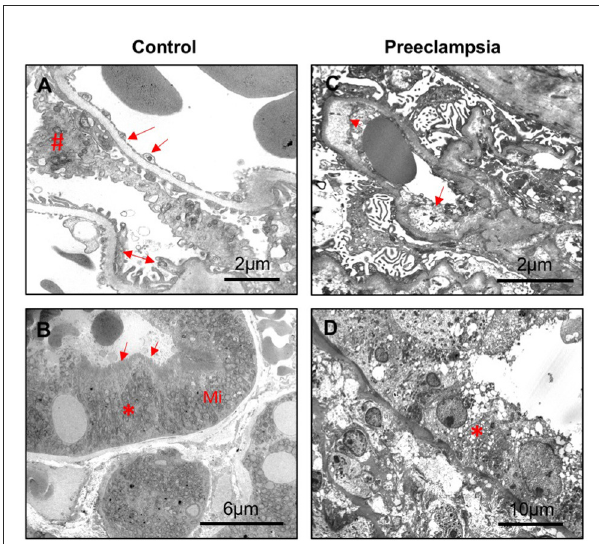
FIGURE3 Representative electron microscopy of kidney tissue sections from a control and a preeclamptic cases. (A, B) control; (C, D) preeclampsia. (A) Segment of glomerulus showing wide opened capillary loops covered by basement membrane and podocyte foot processes; endothelial lining is highly fenestrated. Arrow: glomerular endothelial cell; #podocyte; and double arrow: foot processes. Scale bar = 2 microns. (B) Segment of proximal tubule epithelial cells (*) showing dense mitochondria (Mi) at the base of tubule epithelial cells and well-preserved brush borders (arrow). Scale bar = 6 microns. (C) Glomeruli showing diffuse effacement of foot processes, widening of subendothelial spaces (arrowhead), significant endothelial edema (arrow), and enlarged endothelial nuclei. Scale bar = 2 microns. (D) Proximal tubule epithelial cells showing cytoplasm vacuolization (*), apical blebbing, and diffuse loss of brush borders. Scale bar = 10